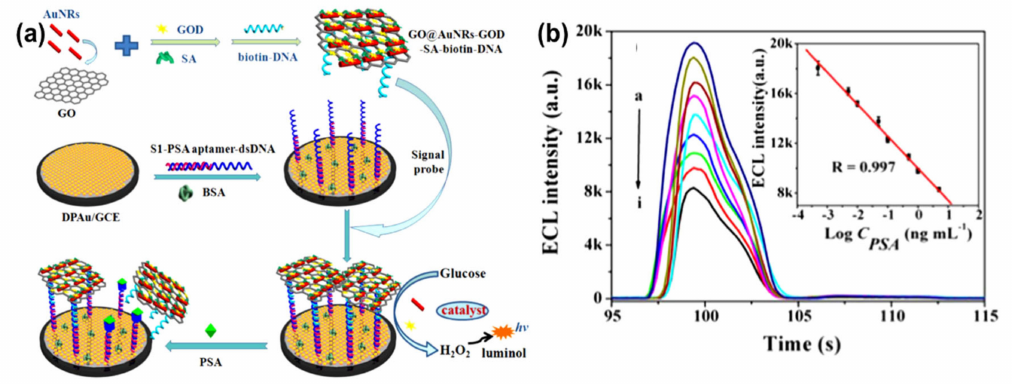
Figure 13. ( a ) Schematic diagram of GO–AuNRs multi-labeled with glucose oxidase and streptavidin toward luminol-based electrochemiluminescence (ECL) aptasensor for prostate-specific antigen detection. ( b ) Electrochemiluminescence intensity changes with prostate-specific antigen (PSA) concentrations (ng / mL), insert: The detection of prostate-specific antigen calibration curve. Adapted from [42], with permission from Elsevier,